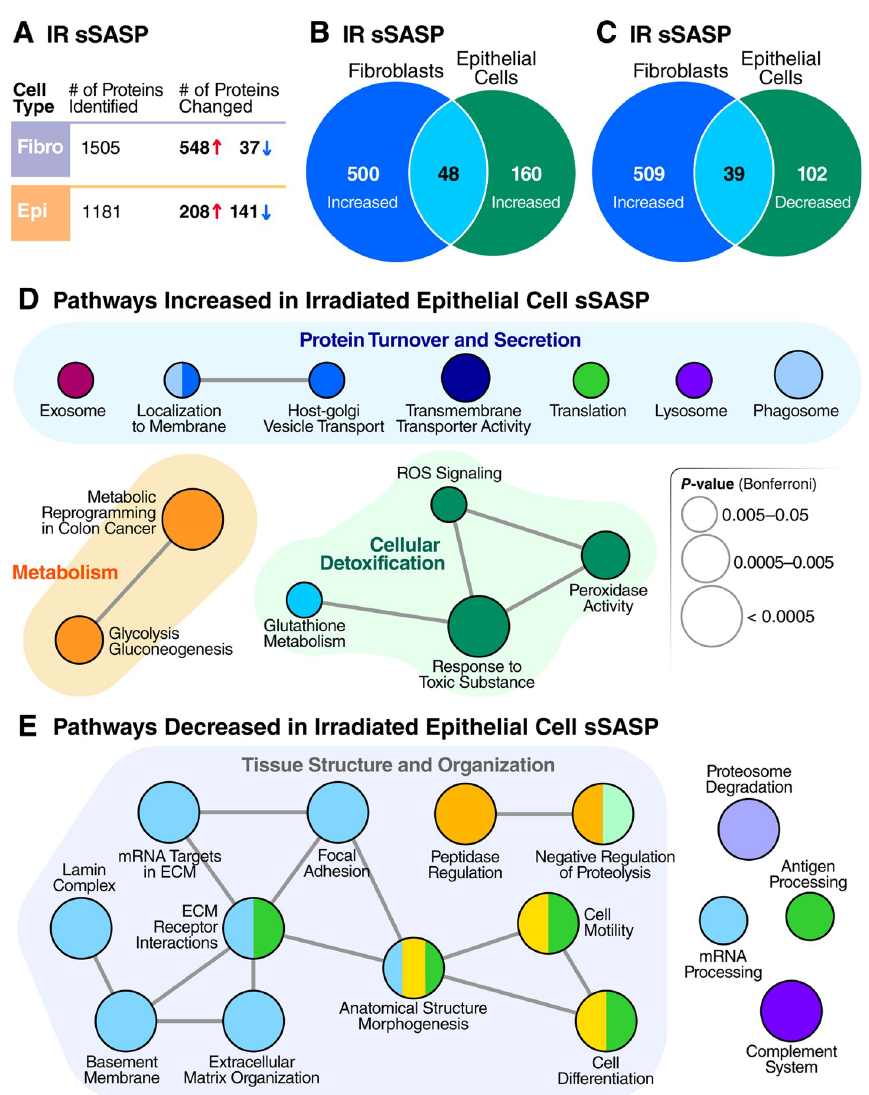
Fig 4. Epithelial cells and fibroblasts exhibit distinct sSASPs. (A) Number of proteins identified and significantly altered in the sSASP of irradiated fibroblasts and epithelial cells. (B) Venn diagram comparing proteins significantly increased in the sSASPs of senescent fibroblasts and epithelial cells, both induced by IR (q < 0.05). (C) Venn diagram comparing protein increases in the fibroblast sSASP versus decreases in the epithelial sSASP. (D) Pathway and network analysis of secreted proteins significantly increased in epithelial cell sSASP. (E) Pathway and network analysis of proteins significantly decreased in the epithelial cell sSASP. ECM, extracellular matrix; IR, X-irradiation; ROS, reactive oxygen species; sSASP, soluble senescence-associated secretory